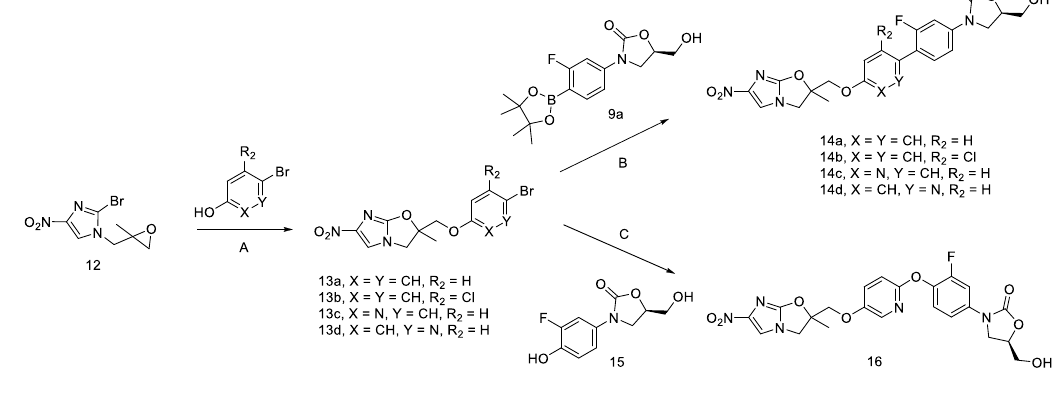
Scheme 1. Synthesis of Conjugate Molecules 8a–b and 11a – b.